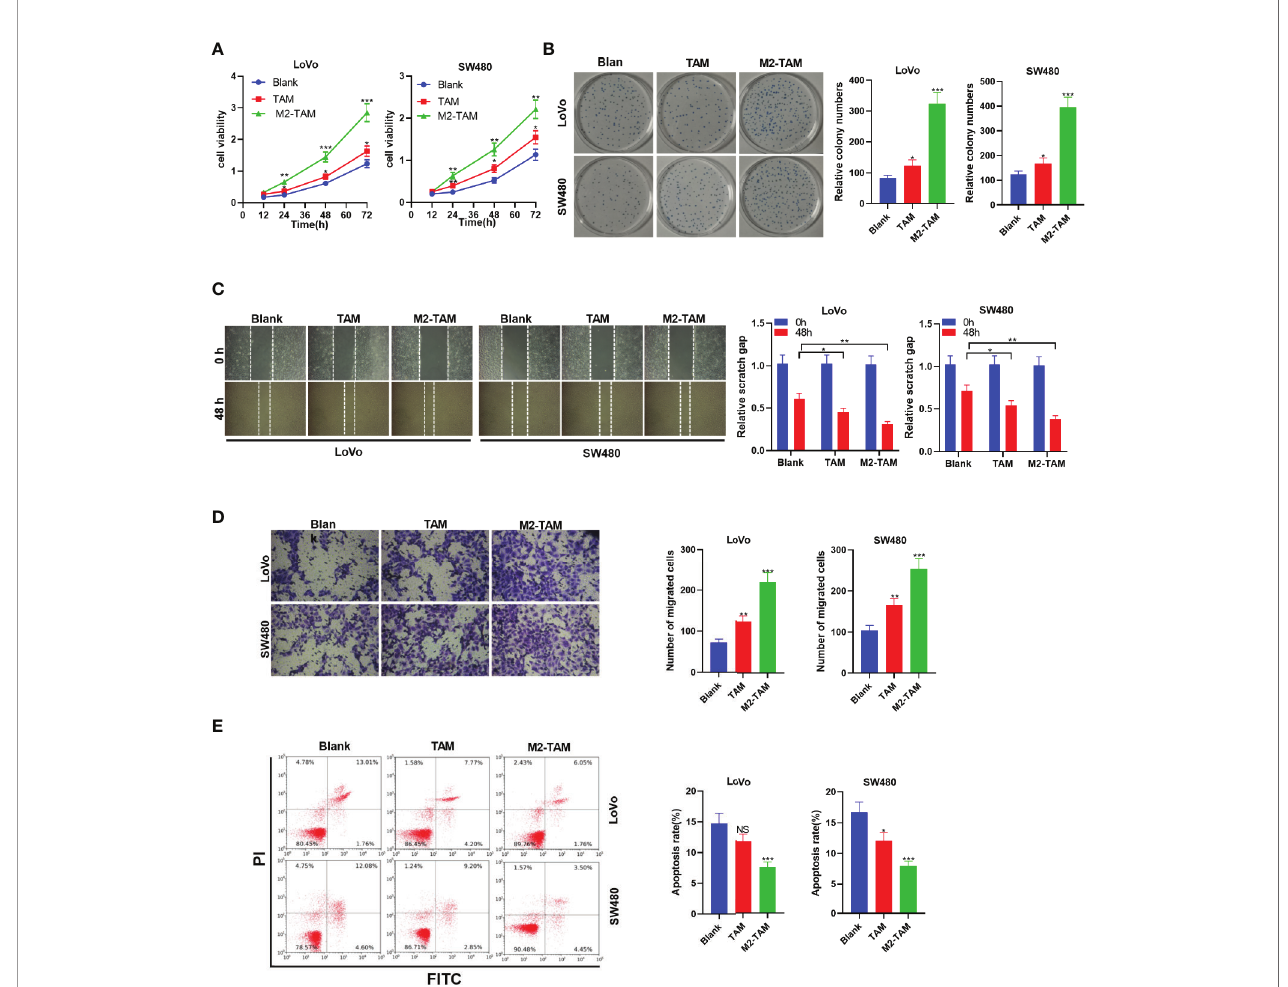
FIGURE 1 | M2-polarized macrophages heightened the proliferation, migration, invasion, and attenuated apoptosis in CC. M2-TAM was co-cultured with LoVo and W480 cells, respectively. (A) CCK-8 assay was utilized to verify CC cell proliferation. (B) The colony formation experiment was implemented to determine cell colony formation. (C) Detection of cell migration by wound healing test. (D) Cell invasion was tested by Transwell assay. (E) Apoptosis was examined by FCM. ns P > 0.05, * P < 0.05, ** P < 0.01, *** P < 0.001 ( vs . Blank group).